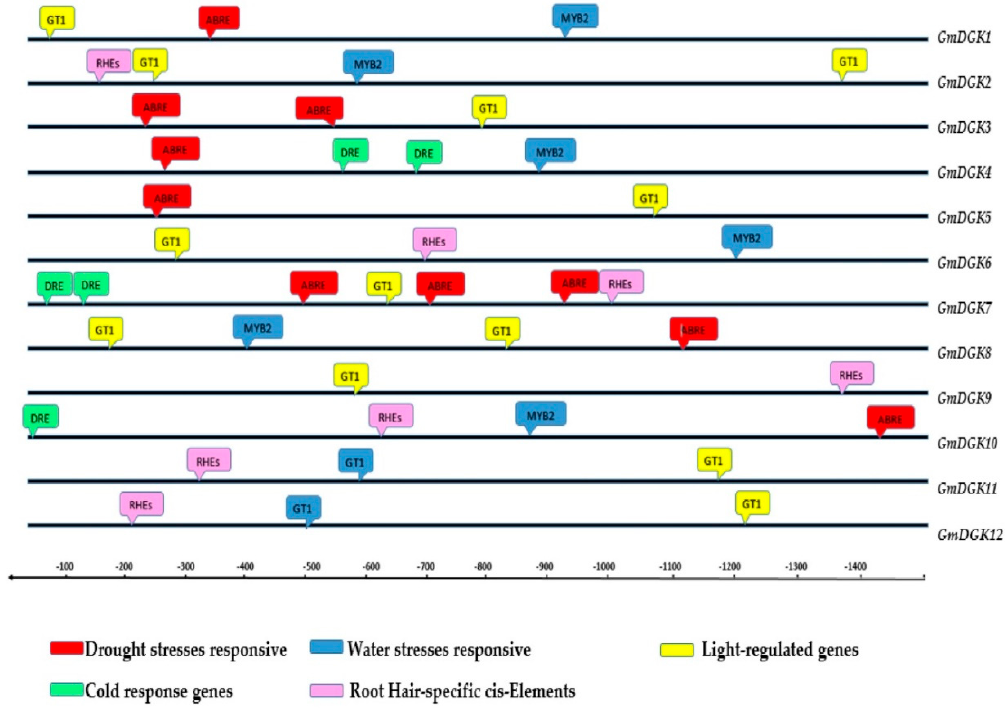
Figure 10. Illustration of five selected cis-regulatory units in all promoters of the DGK gene in soybean. From the translation start site, the upstream region from − 1500 to − 100 shows the upstream region of each DGK promoter. Several units including ABRE , GT1 , RHe , MYB2 , and DRE all exist in the promoter.